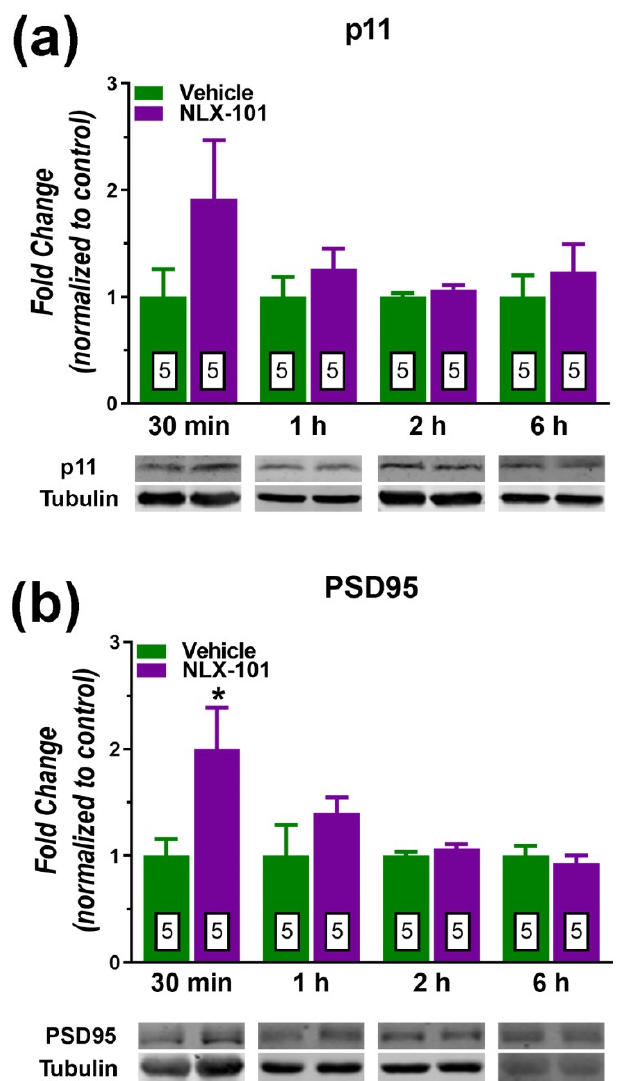
Figure 5. Effects of NLX-101 (0.16 mg/kg) and vehicle (Veh) on the concentration of postsynaptic proteins p11 ( a ) and PSD95 ( b ) in the prefrontal cortex at 30 min, 1 h, 2 h and 6 h after its intraperitoneal administration. Results are expressed as mean ± SEM. Number of animals is indicated within the bars. * p < 0.05 compared with the corresponding vehicle group (two-tailed Student’s t -test). In contrast, brain-derived neurotrophic factor (BDNF) (Figure 6a) and pAkt (Figure 6b) and GluA1 (Figure 6c) displayed a more delayed response to the administration of NLX-101. The expression of BDNF was significantly elevated at 1 h ( t = 2.478, df = 8, p < 0.05) and 2 h after drug administration ( t = 2.571, df = 8, p < 0.05), whereas the increase in the level of pAkt was significant at 2 h ( t = 2.742, df = 8, p < 0.03) and 6 h ( t = 3.273, df = 8, p < 0.02) after NLX-101. The expression of GluA1 subunit also increased significantly 2 h (+74%, t = 2.229, df = 10; p < 0.05, two-tailed Student’s t -test) after NLX-101 administration. NLX-101 did not alter the synthesis of β -arrestin 1 and β -arrestin 2 (Figure 7) at any of the tested time points. A schematic representation of the molecular signaling mechanisms involved in the antidepressant-like effects of NLX-101 is depicted in Figure